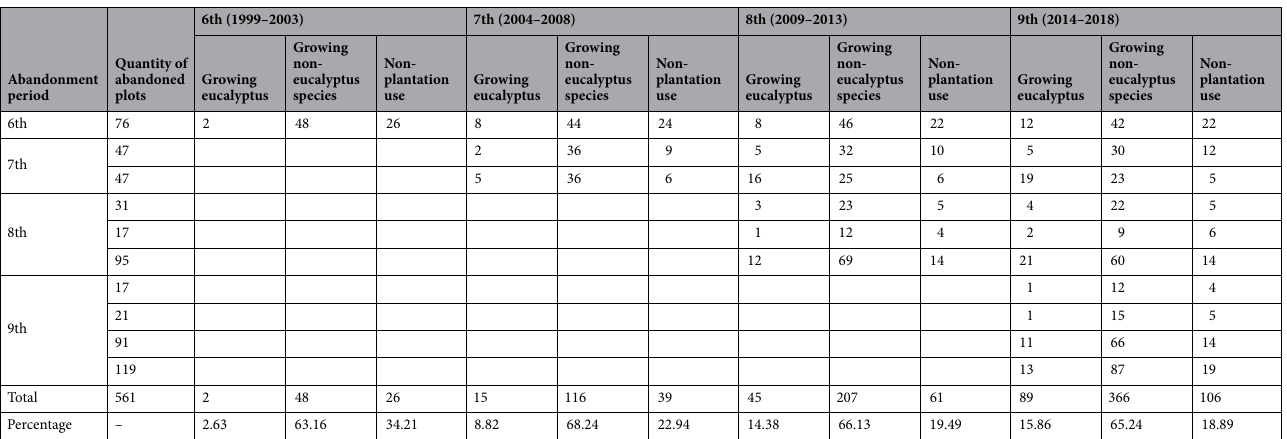
Table 8. Land use of eucalyptus plantation sample plots during different NFIs. For example, in the 6th NFI, 2, 48, and 26 sample plots from the 5th NFI are used for growing eucalyptus, non- eucalyptus species, and non- plantation use,